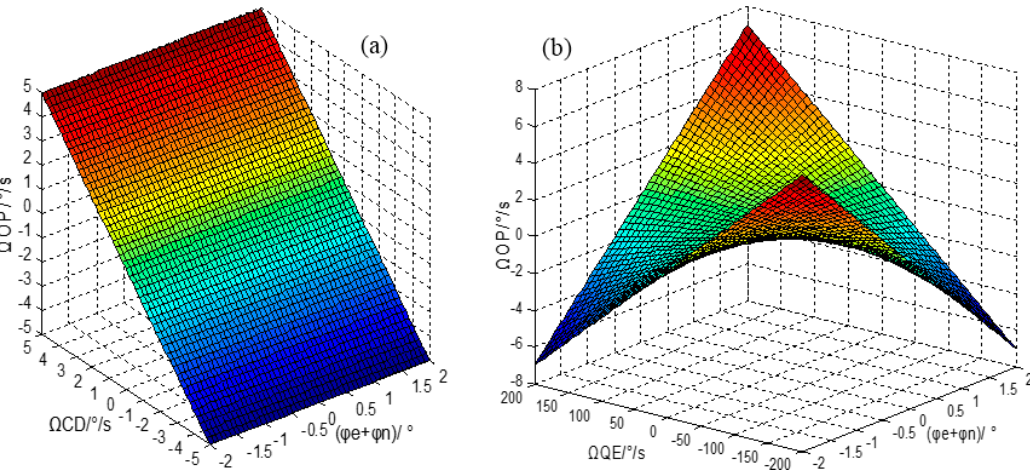
Figure 2. ( a ) The relationship between Ω OP , φ e + φ n and Ω CD ; ( b ) The relationship between Ω OP , φ e + φ n and Ω QE .